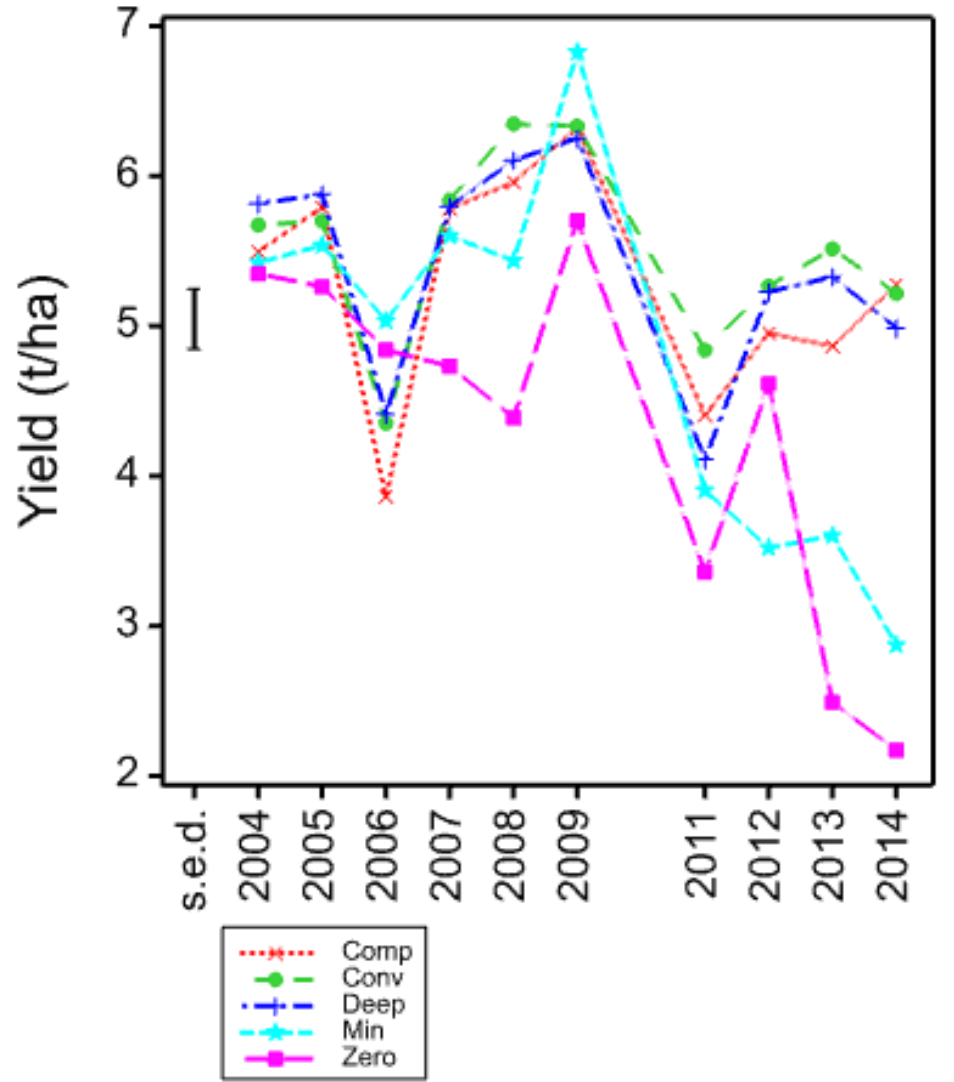
Figure 2. Mean yield of the four core set cultivars—tillage treatment interactions for 2004–2014.